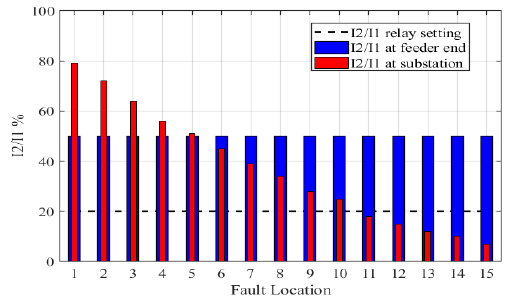
Figure 11. Negative to positive sequence percentage current ratio.